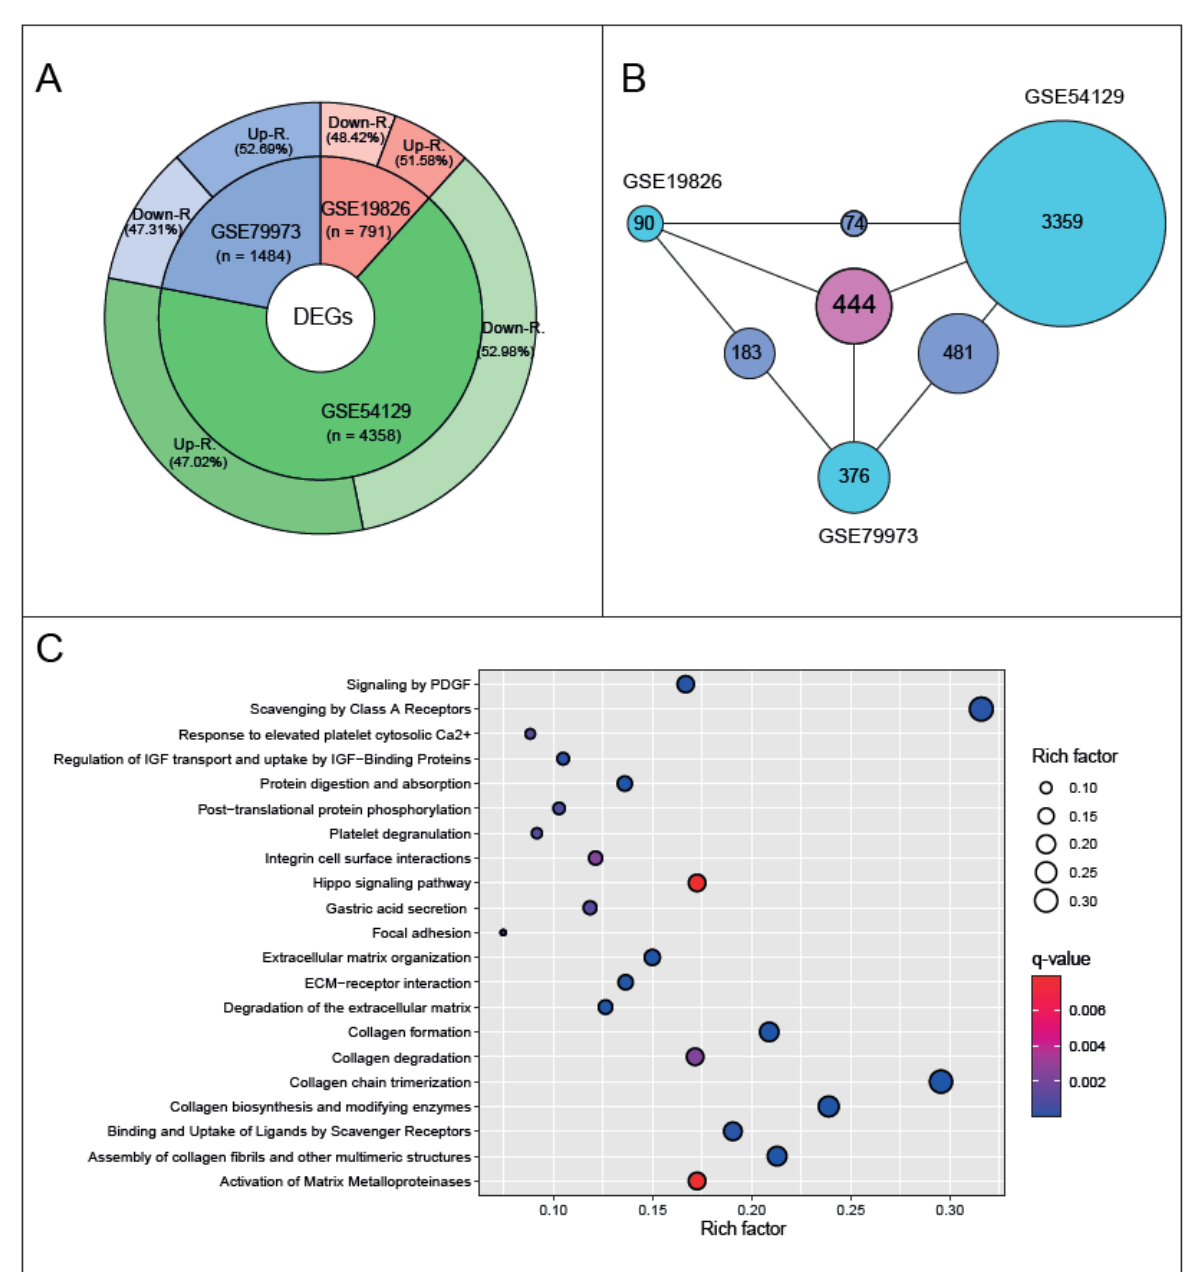
Figure 2. Meta-analysis of the three transcriptome datasets associated with gastric cancer. ( A ) Pie donut diagram shows the distribution of differentially expressed genes (DEGs) of the three transcriptome datasets. ( B ) The Venn diagram shows the DEGs common to the datasets. ( C ) The gene set overrepresentation analysis of the common DEGs.